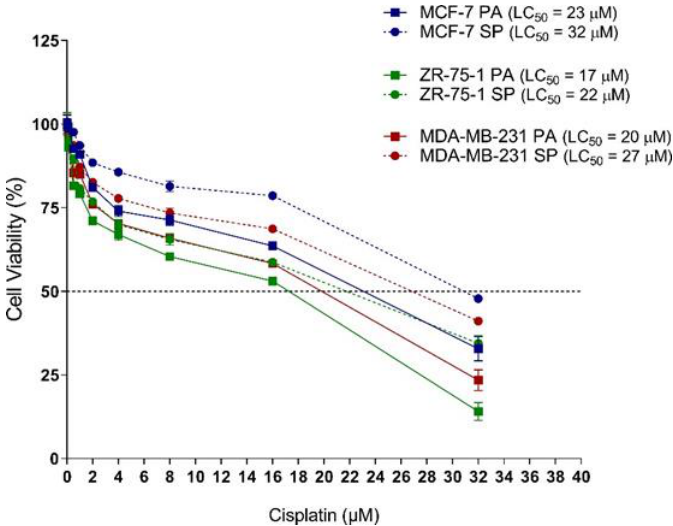
Figure 6. 3rd generation spheroids have increased chemoresistance to cisplatin compared to mono-